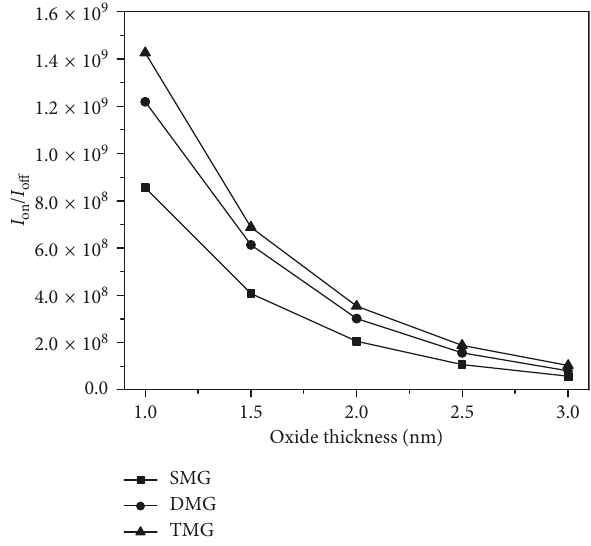
Figure 10: I on / I off for SMG, DMG, and TMG Re-S/D SOI MOSFET versus oxide